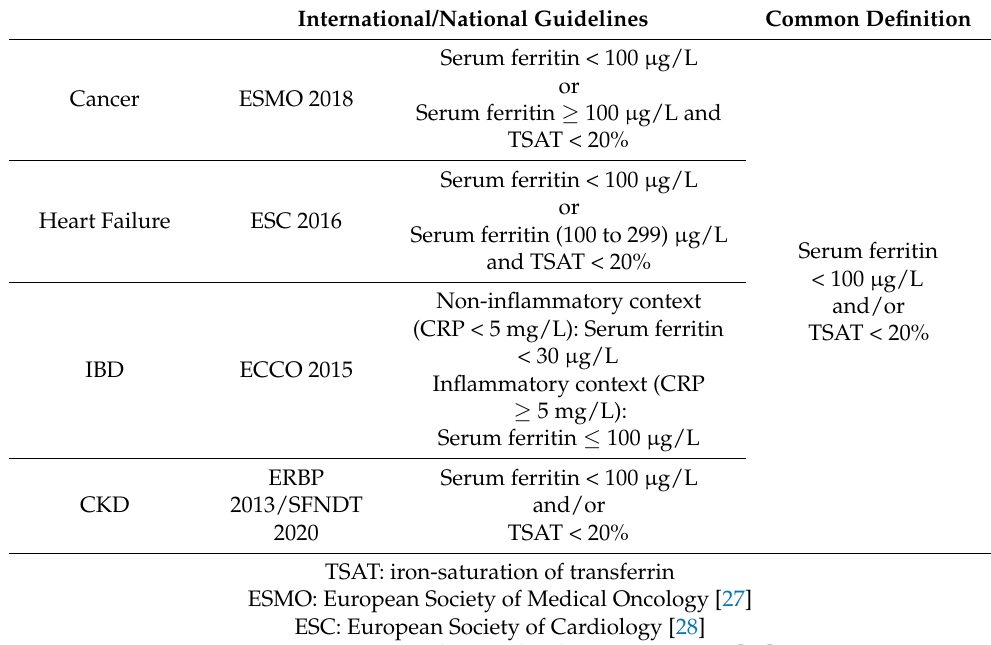
Table 1. Definition of iron deficiency (ID) in CARENFER study patients with cancer, heart failure, chronic inflammatory bowel disease (IBD), or chronic kidney disease (CKD) according to both international or national guidelines and our common